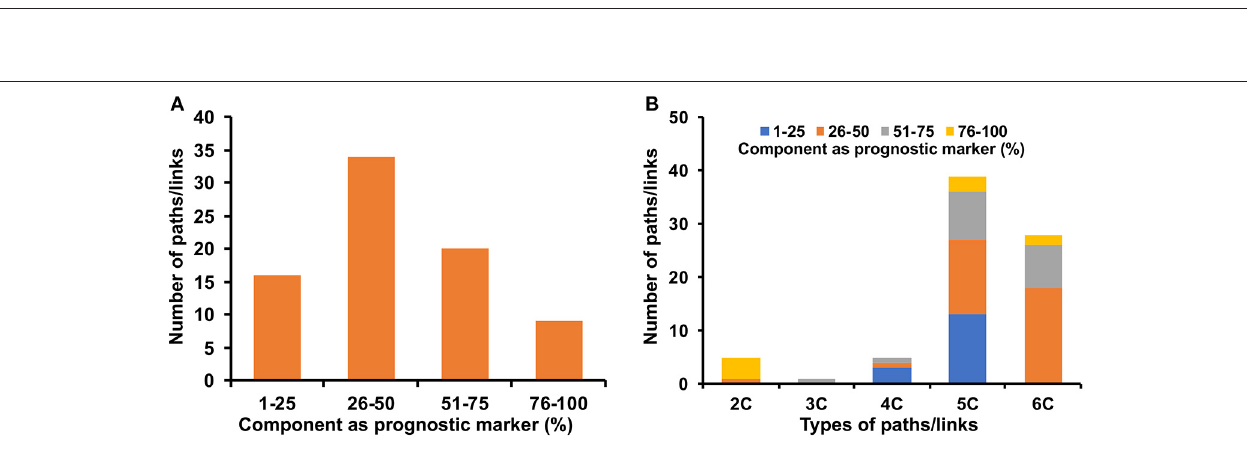
Frontiers in Medicine |